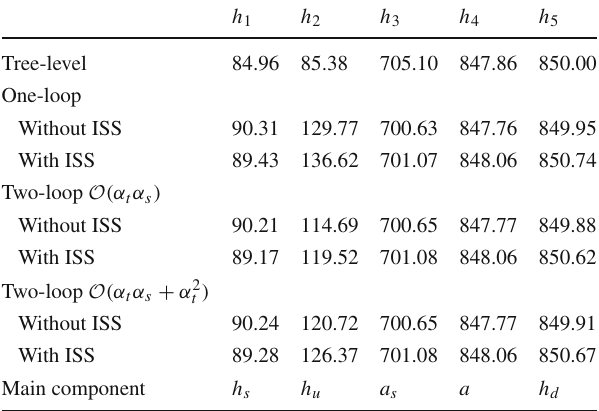
(cid:2) (cid:3) α + α 2 α obtained for the NMSSM t s t